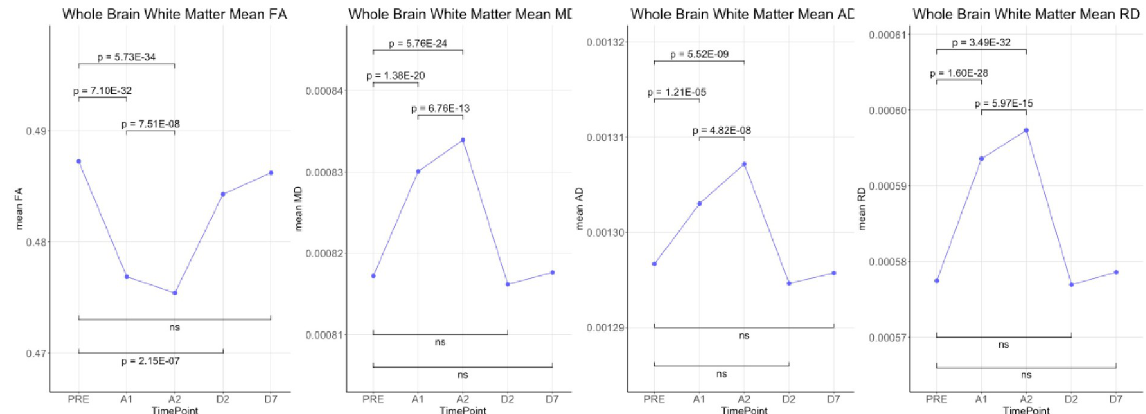
Fig 2. Statistical comparisons of whole brain means of DTI metrics (FA, MD, AD and RD) over the 5 time-points.